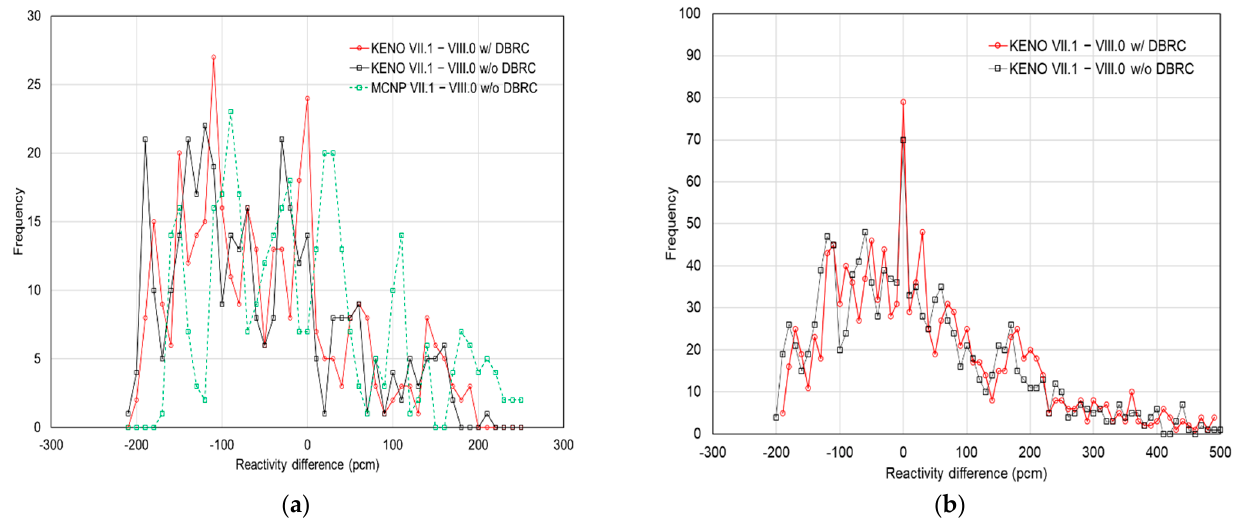
Figure 3. Histogram of the extensive PWR ( a ) pin and ( b ) assembly benchmark results. Table 7. Results of the extensive PWR pin benchmark problems. Reactivity Differences between ENDF/B-VIII.0 and VII.1 (pcm) KENO with DBRC KENO without DBRC Average S. Dev. Min.